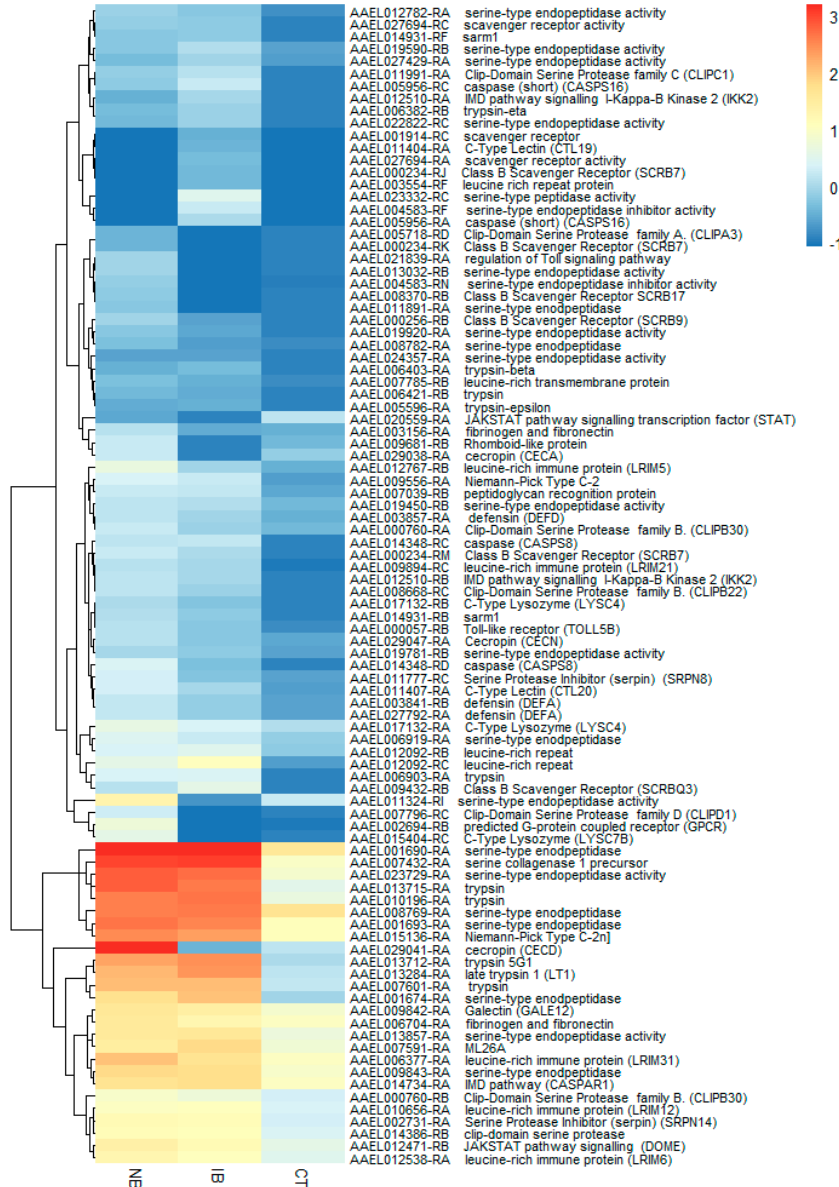
Figure 3. Heatmap showing the expression profile of 94 immune-related transcripts (IRT) transcripts found upregulated .